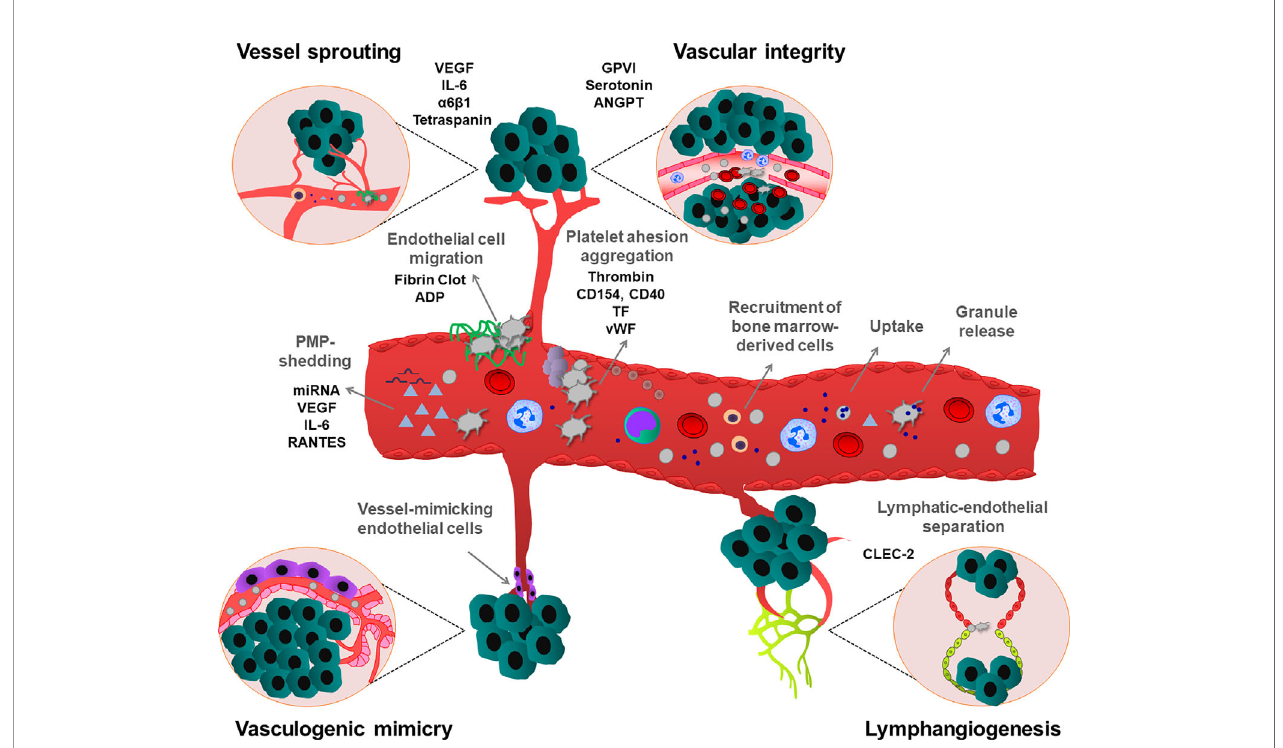
FIGURE 2 | Effects of platelets on different types of tumor angiogenesis and maintenance of vascular integrity. Platelets stimulate tumor neovascularization by multiple mechanisms. Platelets induce secretion of pro-angiogenic growth factors, from tumor and tumor microenvironment. Platelets can also uptake and sequester pro-angiogenic mediators from the tumor and surrounding environment and deliver and release them into the tumor. Additionally, PMPs enhance vessel formation. Platelets also stimulate the recruitment of bone marrow-derived cells to the angiogenic tumor tissues. Platelets attach to activated endothelium, thereby inducing the migration of endothelial cells on a platelet-rich fi brin matrix. Besides, platelets can maintain the integrity of tumor vessels, preventing hemorrhages, thereby enhancing the survival of growing tumors. Platelets also maintain the lymphatic-endothelial separation during tumor lymphangiogenesis. In contrast to their activatory roles in other angiogenesis types, vasculogenic mimicry-induced tumor angiogenesis is inhibited by platelets. As shown, all these processes can be regulated by platelet- mediated processes involving different cellular and molecular